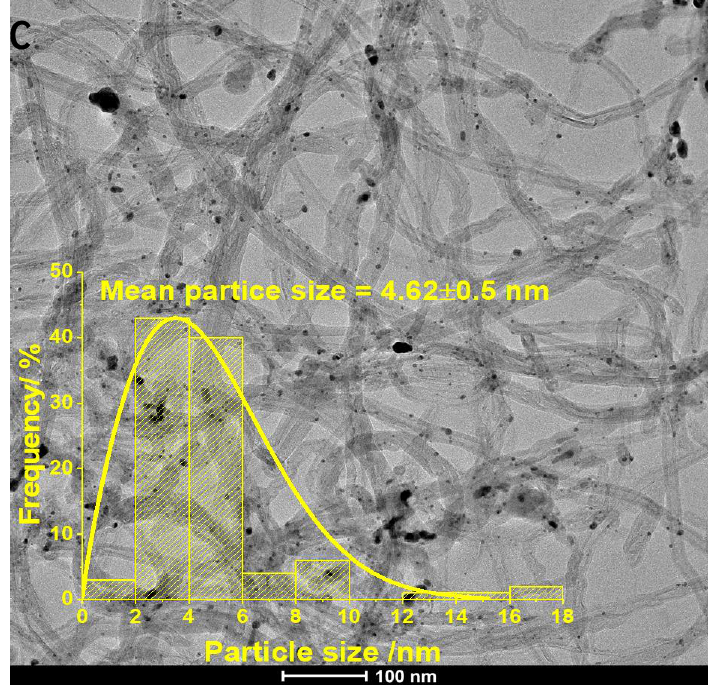
Figure 2. Transmission electron microscopy for ( A ) Pd 1 Co 1 /N-rGO catalyst, ( B ) Pd/N-rGO, and ( C ) Pd 1 Co 1 /CNT.